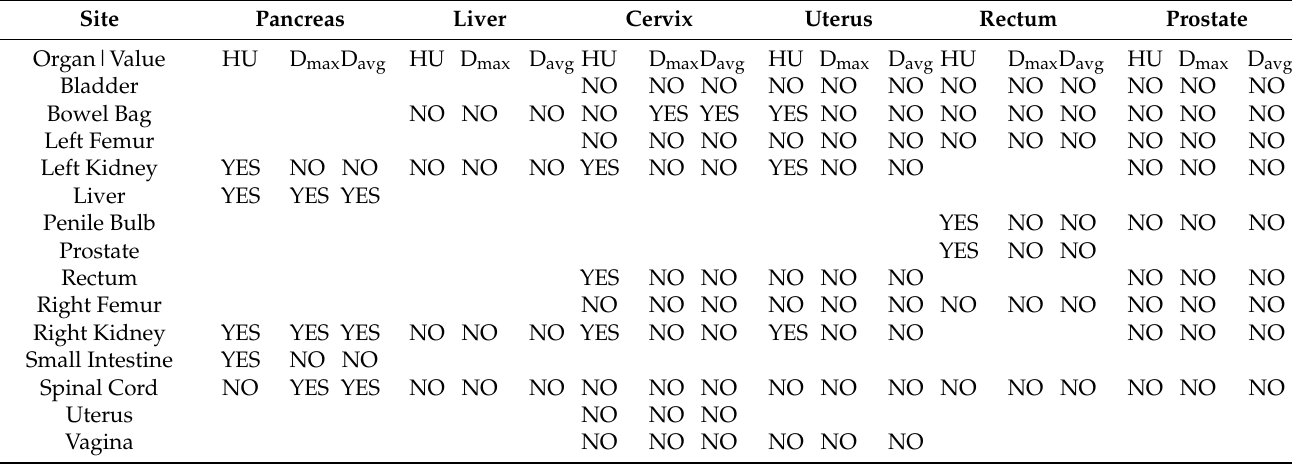
Table 5. Summary of statistical analysis results for critical structures in brain and abdomen and pelvis. “YES” indicates statistically significant difference in CT number (HU), maximum dose (D max ), and mean dose (D avg ) values between NCCT and CCT images, and “NO” is vice